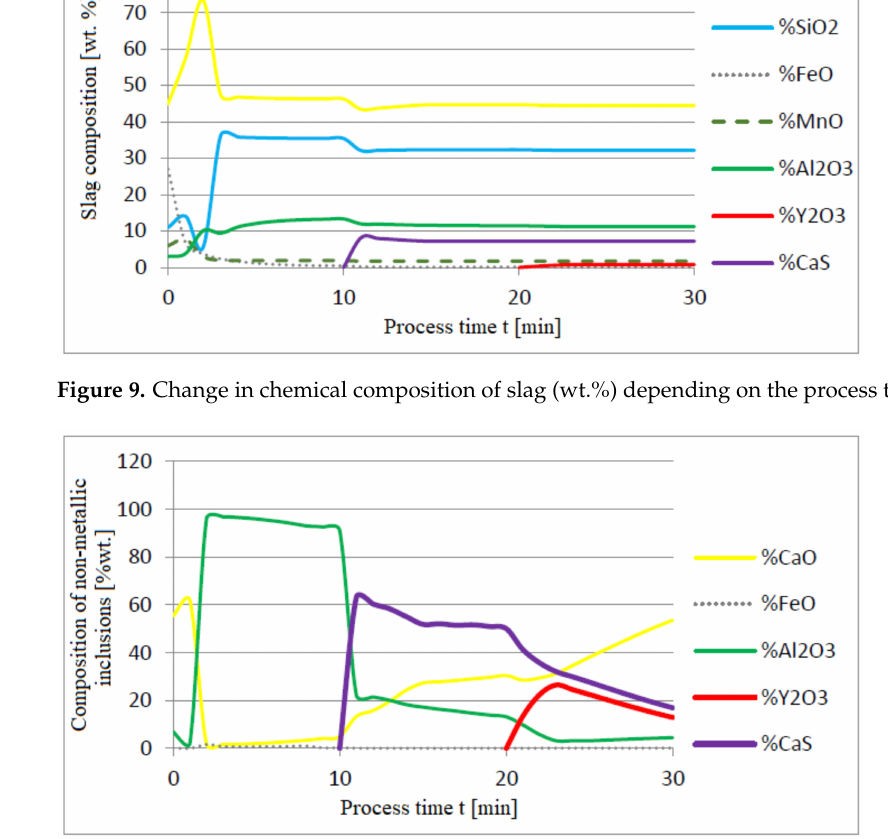
Figure 10. Change in chemical composition of non-metallic inclusions (wt.%) depending on the process time.